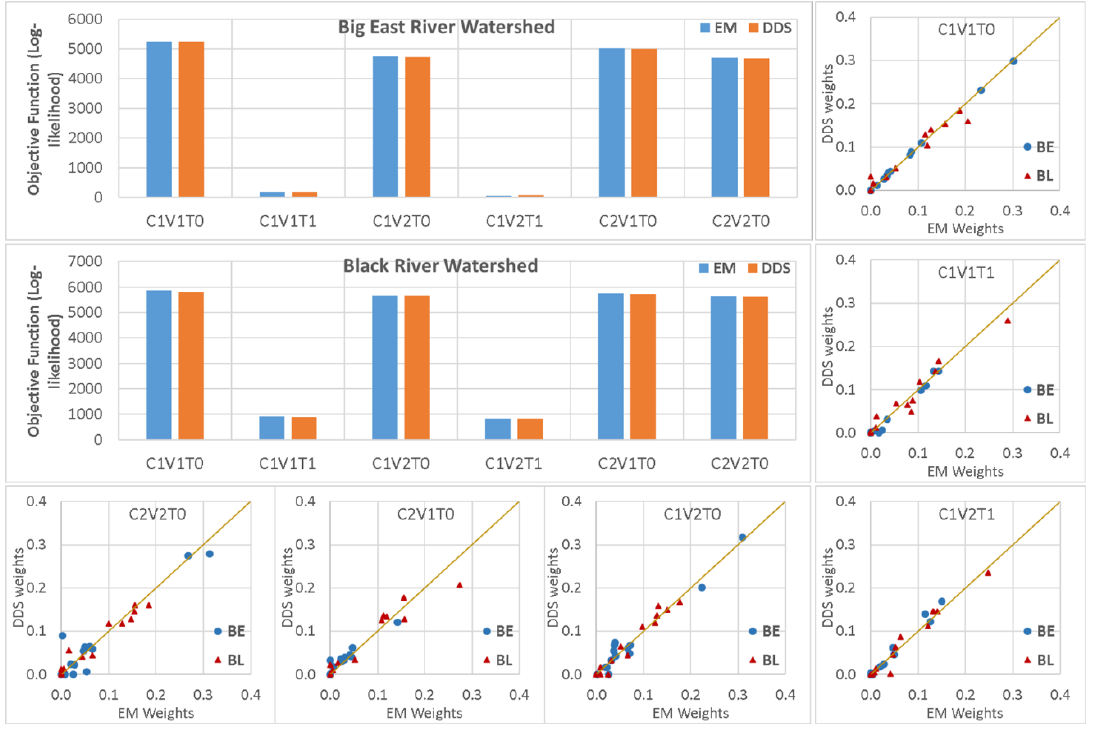
Figure 10. A comparison of the log-likelihood and weights of the calibrated BMA models using dynamically dimensioned search (DDS) and expectation-maximization (EM) algorithms as the optimization